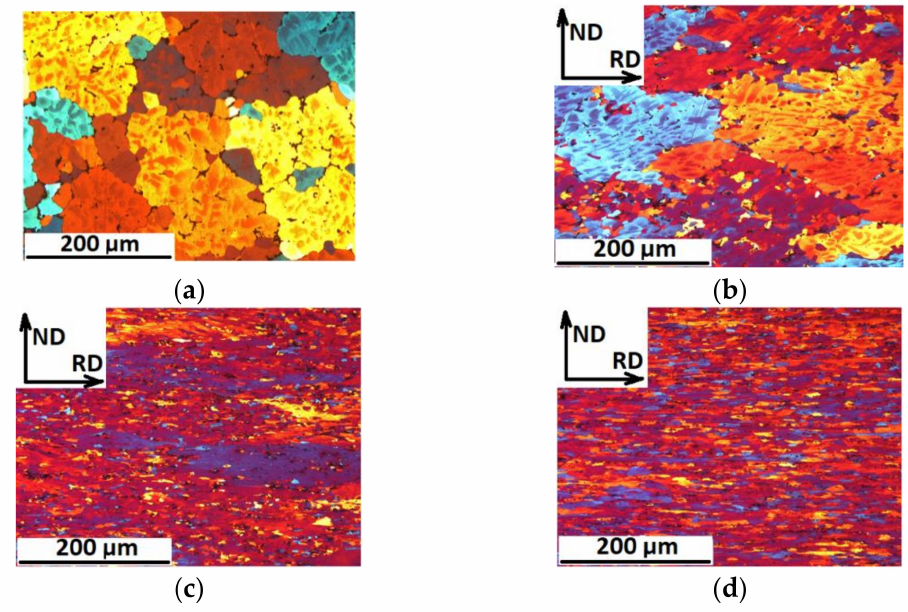
Figure 3. Microstructure of 1565 alloy specimen: ( a ) cast specimen, ( b ) 32.2% deformation, ( c ) 67.13% deformation, ( d ) 83.53%